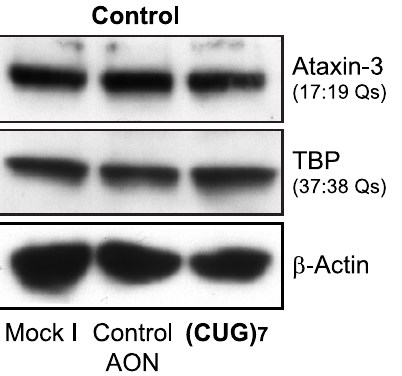
Figure 8. (CUG) 7 AON does not reduce other polyQ-containing proteins. Western blot of control (FLB73) fibroblasts treated with 100 nM (CUG) 7 , non-htt specific h40AON2 (Control AON), and non- transfected (Mock I). TATA box binding protein (TBP) and ataxin-3 are not reduced 72 hours after treatment with (CUG) 7 . b -actin is used as loading